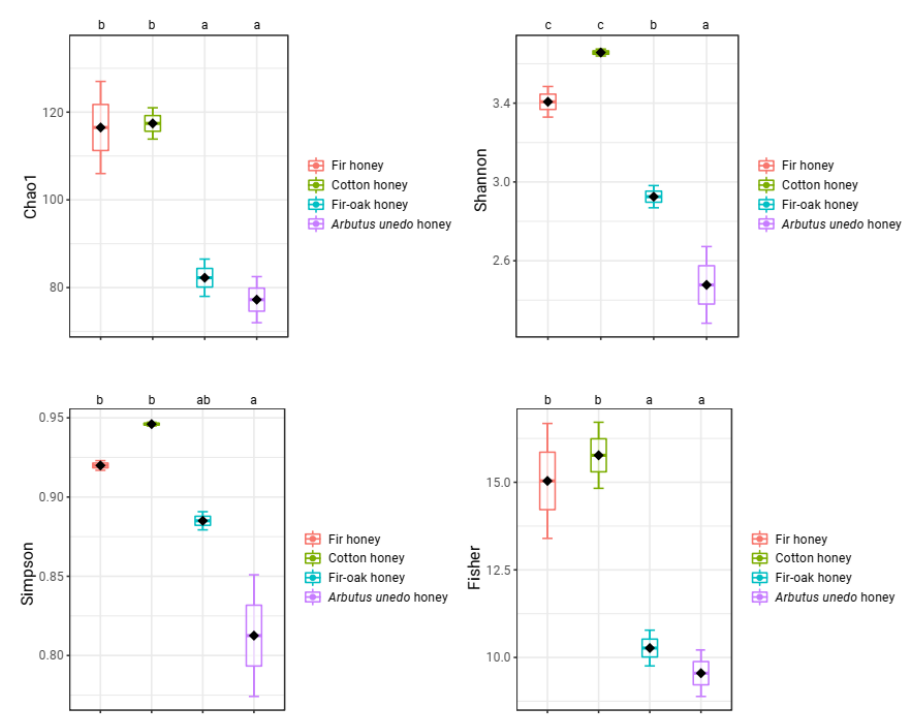
Figure 1. Diversity indices of the examined honey samples. Bars represent ± standard errors of means. Analysis of variance (ANOVA) using Duncan’s multiple post hoc tests at a significance level of 5% ( a < 0.05 ) were carried out to identify statistically significant differences. No letter in common at the top of the subgraphs is indicative of statistically significant differences.